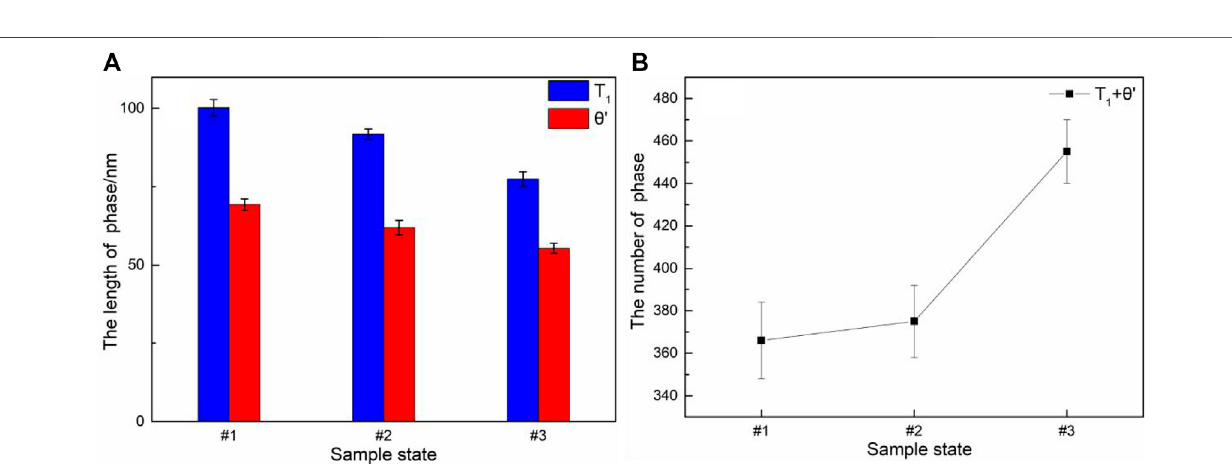
FIGURE 9 | Length and quantity relation of T 1 and θ ′ phases. (A) average length, (B)